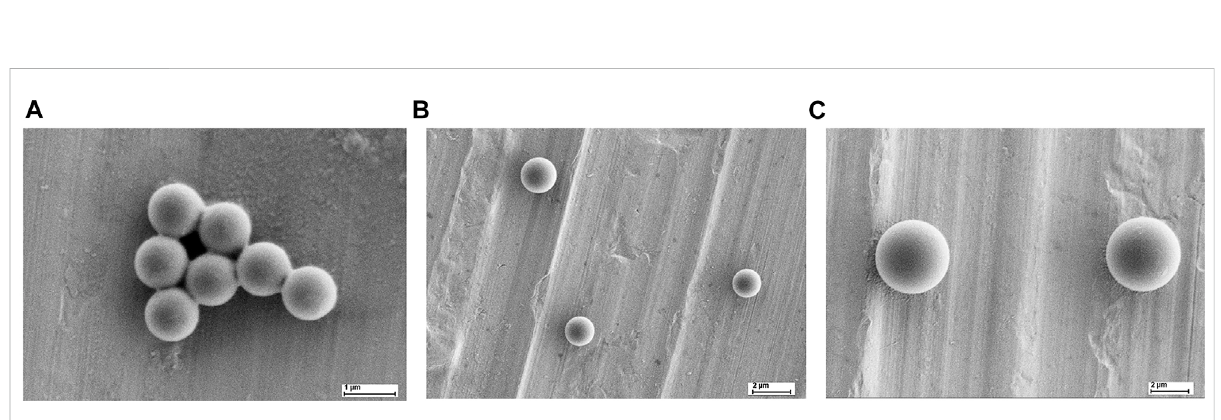
FIGURE 2 Images of three particles scanning under electron microscope (A) 1 µm (B) 2 µm and (C) 4